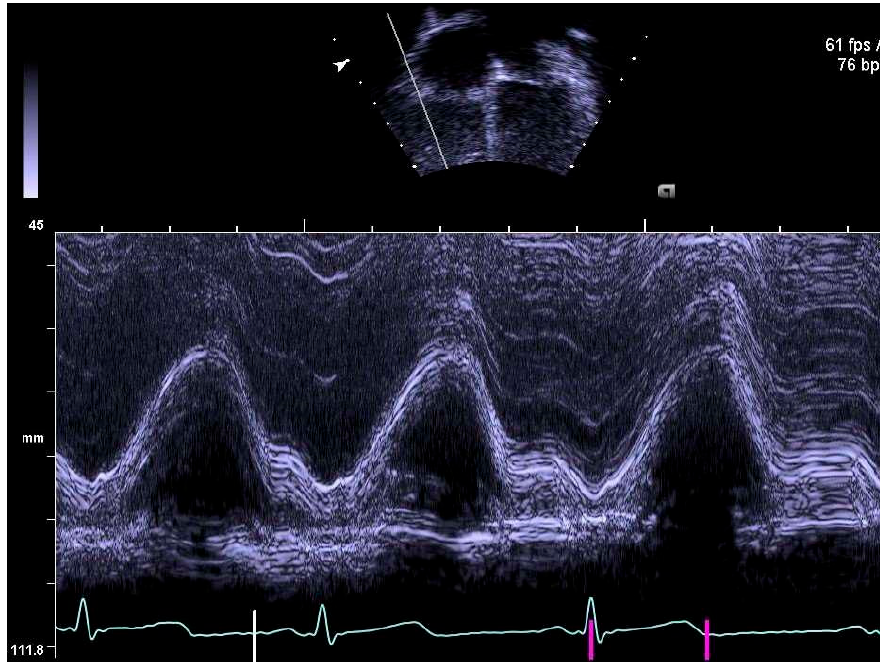
Figure 3. Tricuspid annular plane systolic excursion, TAPSE, measured by M-mode.